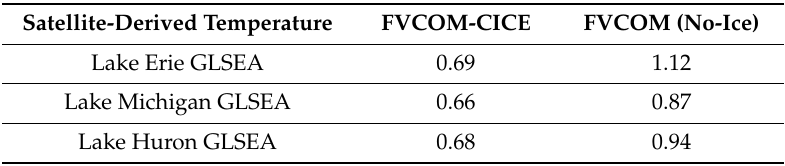
Table 4. Surface water temperature RMSE ( ◦ C) between model simulations and observed temperatures from satellite-derived lake surface temperature from the GLSEA during winter months (1 December–30